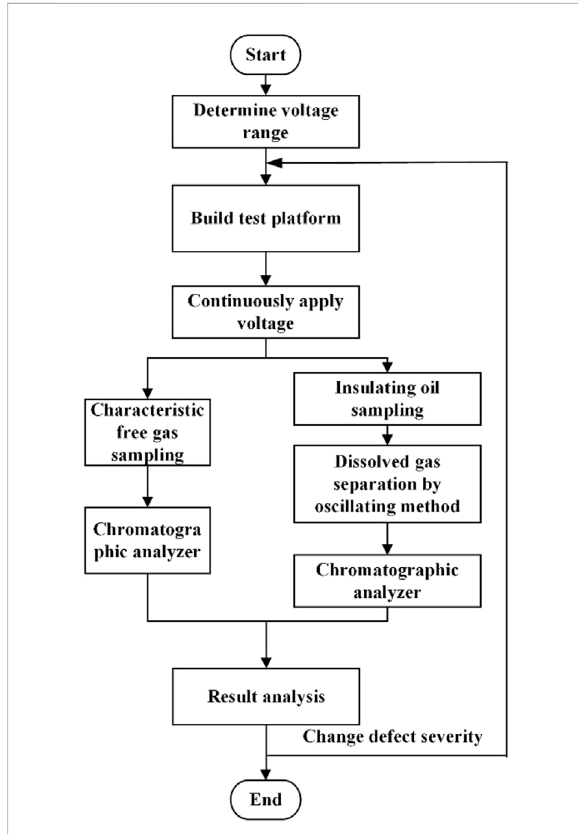
FIGURE 3 Flow chart of free gas detection simulation test for sudden serious discharge fault of